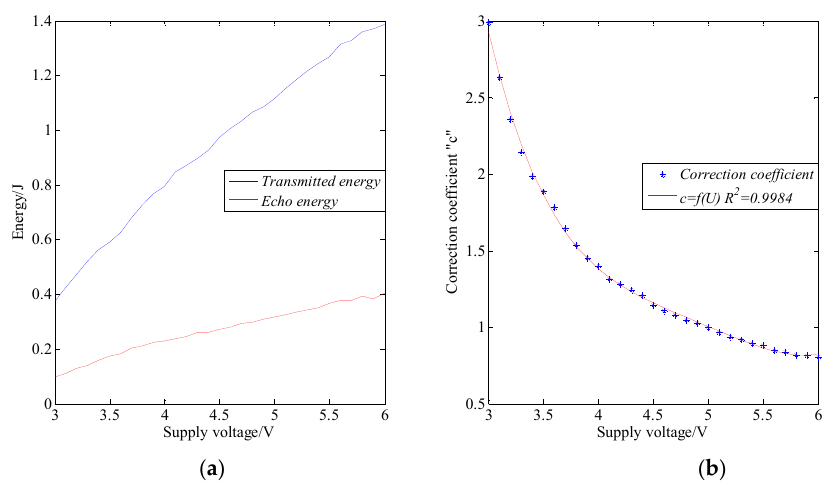
Figure 6. ( a ) Relationship between ultrasonic energy and supply voltage; and ( b ) fitting equation of correction coefficient and supply voltage.